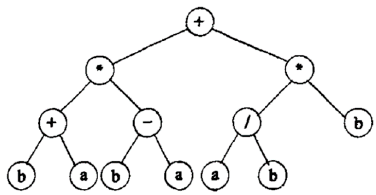
Figure 5. The sample of the gene-expression tree.